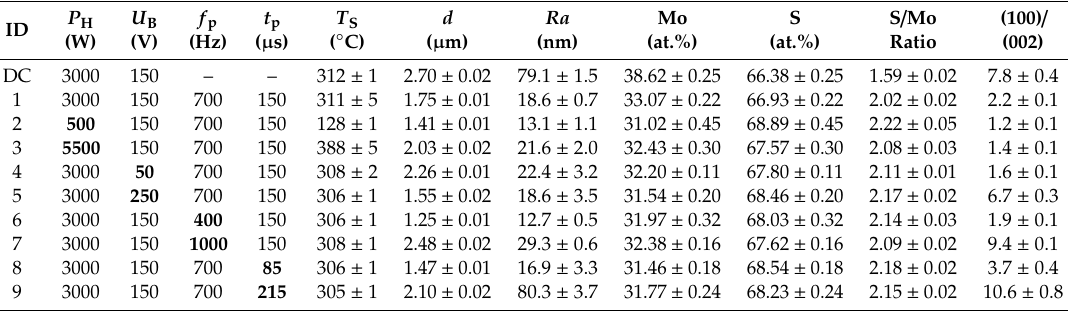
Figure 1. ( a ) Arrangement and target setup in the deposition chamber and ( b ) experimental setup of the ball-on-disc investigations. Table 1. Overview of the deposition parameters and structural properties of the MoS x films, including the substrate temperature T S , coating thickness d , mean roughness Ra and the intensity ratio between the XRD peaks (100) and (002).